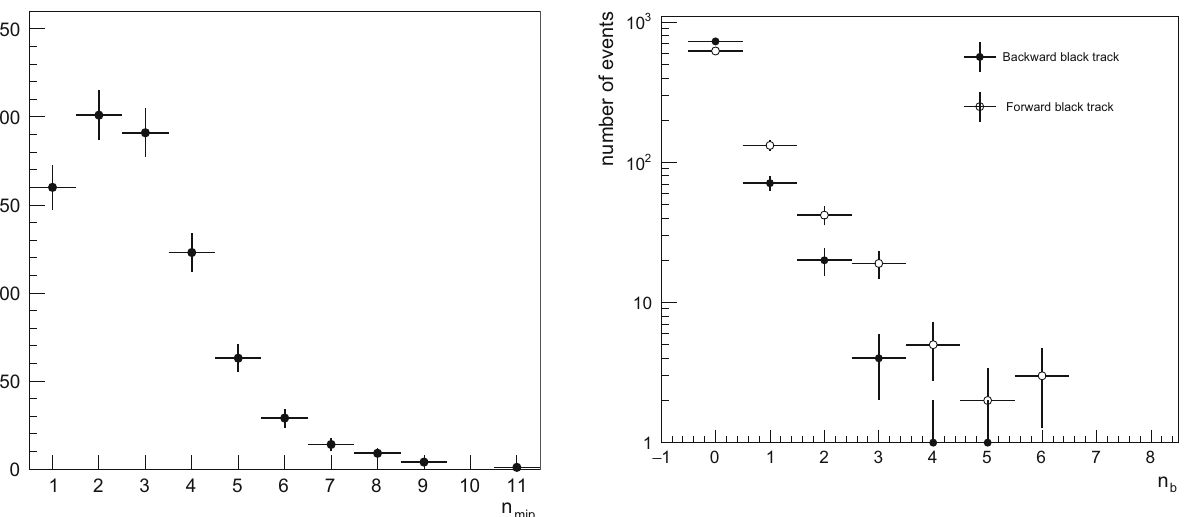
Fig. 3 Multiplicity distribution of mip tracks